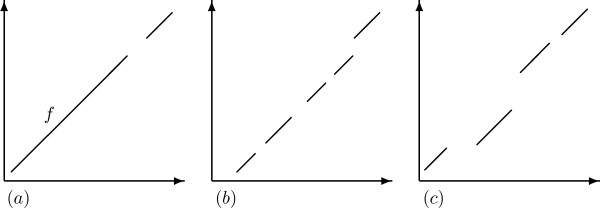
Exclusion of low-scoring regions from alignment fragments. The scoring scheme used in DIALIGN gives relatively high weight scores to single fragments with high Needleman-Wunsch scores (a). In our new approach, we exclude low-scoring sub-regions within long fragments by applying a stop criterion for fragment extension. This can result in the replacement of a long fragment f by multiple sub-fragments (b) or in a completely different alignment (c).